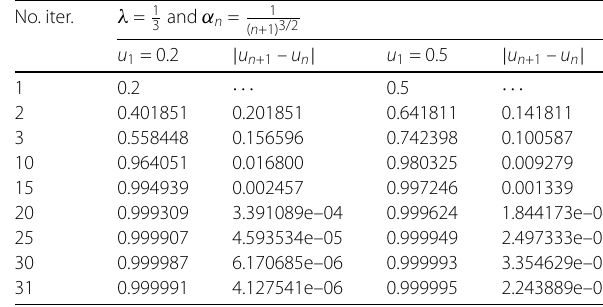
Table 2 Computative iterates and error of Algorithm 1 for the choices of different parameters λ = 1 and α n = 1 , different initial points u 1 = 0.2 and u 1 = 0.5, with the stoping criterion ( n +1) 3/2 | < 10 | u n +1 – u n